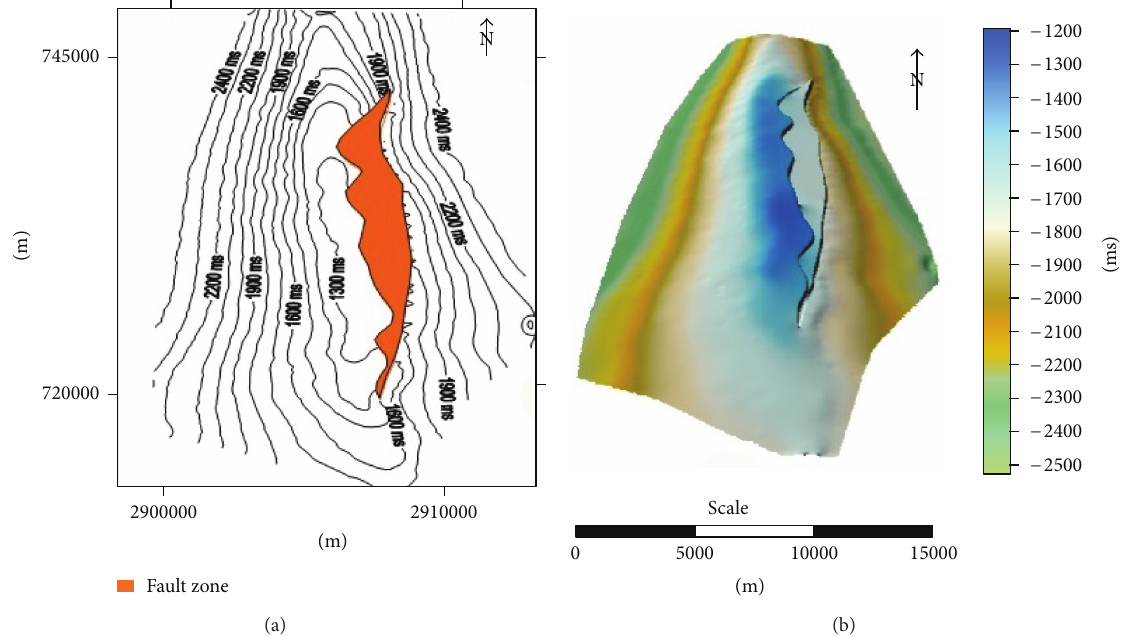
Figure 6: (a) Time structure map on the top of the Upper Gas Sand (R3), Contour interval 100ms. (b) Subsurface relief map on the top of the Upper Gas Sand (R3).